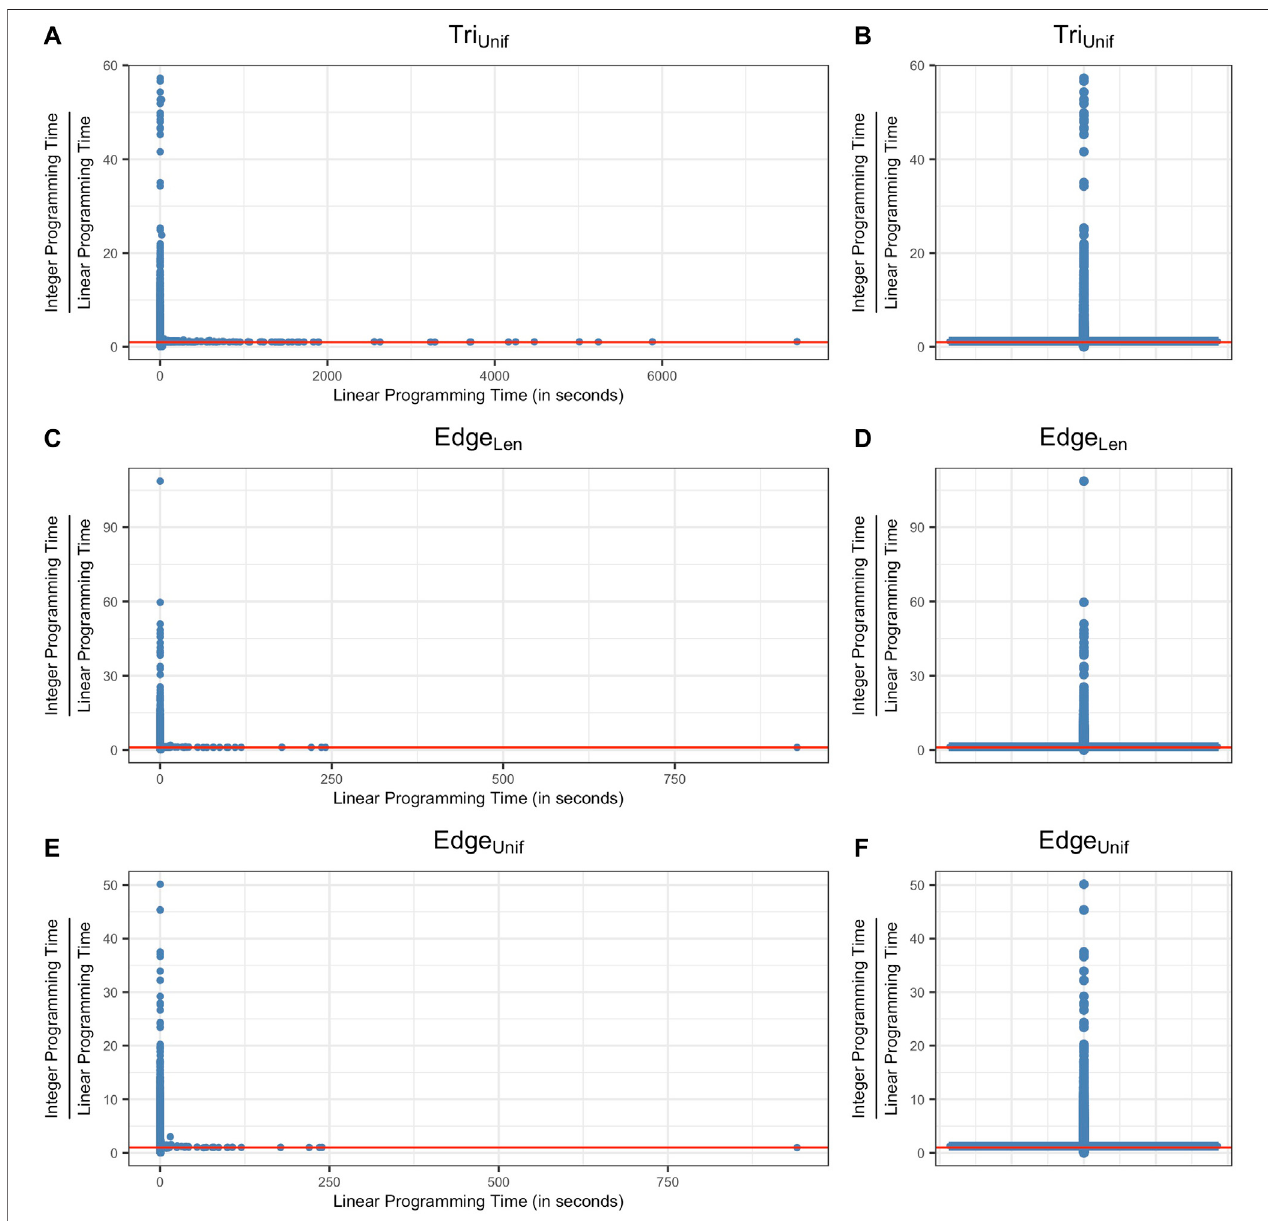
FIGURE6| Ratiobetweenthecomputationtimeofsolvinganintegerprogrammingproblem(ProgramsTri I Unif ,Edge I Len ,Edge NI Unif )andthecomputationtimeofsolvinga linearprogrammingproblem(ProgramsTri NI Unif ,Edge NI Len ,Edge NI Unif )forallofthecyclerepresentativesfromdatasetsdescribedin Sections5.1 , 5.2 and 5.3 .Sub fi gures (A)(C) (E) plotthedatausingscatterplotsandsub fi gures (B)(D)(F) showthesamedatausingboxplots.Theverticalaxisrepresentstheratiobetweentheintegerprogrammingtime andlinearprogrammingtimeofoptimizingacyclerepresentativeandthehorizontalaxisrepresentsthecomputationtimetosolvethelinearprogram.Theredlineineach sub fi gurerepresentsthehorizontalline y (cid:2) 1,wherethetimeforeachoptimizationisequivalent.Aswecanseefromtheboxplots,theratiobetweenthecomputationtimeof integer programming and linear programming for most of the cycle representatives ( > 50%) center around